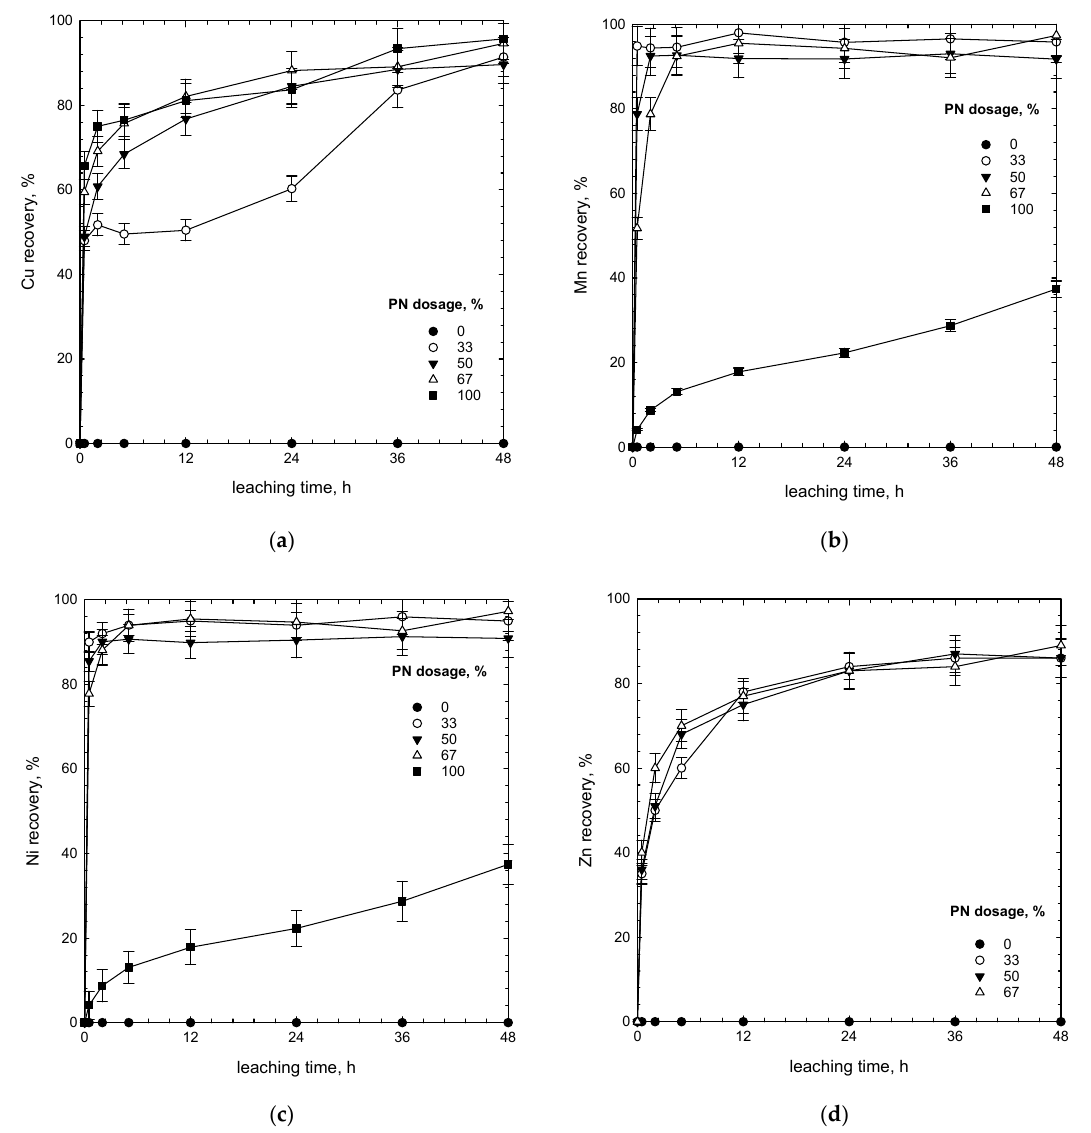
Figure 3. Effect of polymetallic nodules dosage (%) on recovery of ( a ) copper, ( b ) manganese, ( c ) nickel and ( d ) zinc (1 M H 2 SO 4 , 1 M NaCl, 80 °C).